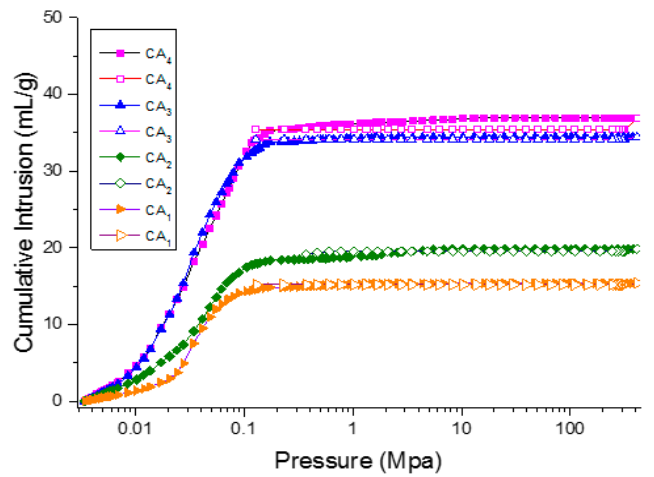
Figure 8. Mercury cumulative intrusion (filled dots) and extrusion curves (hollow dots) of carbon aerogels.